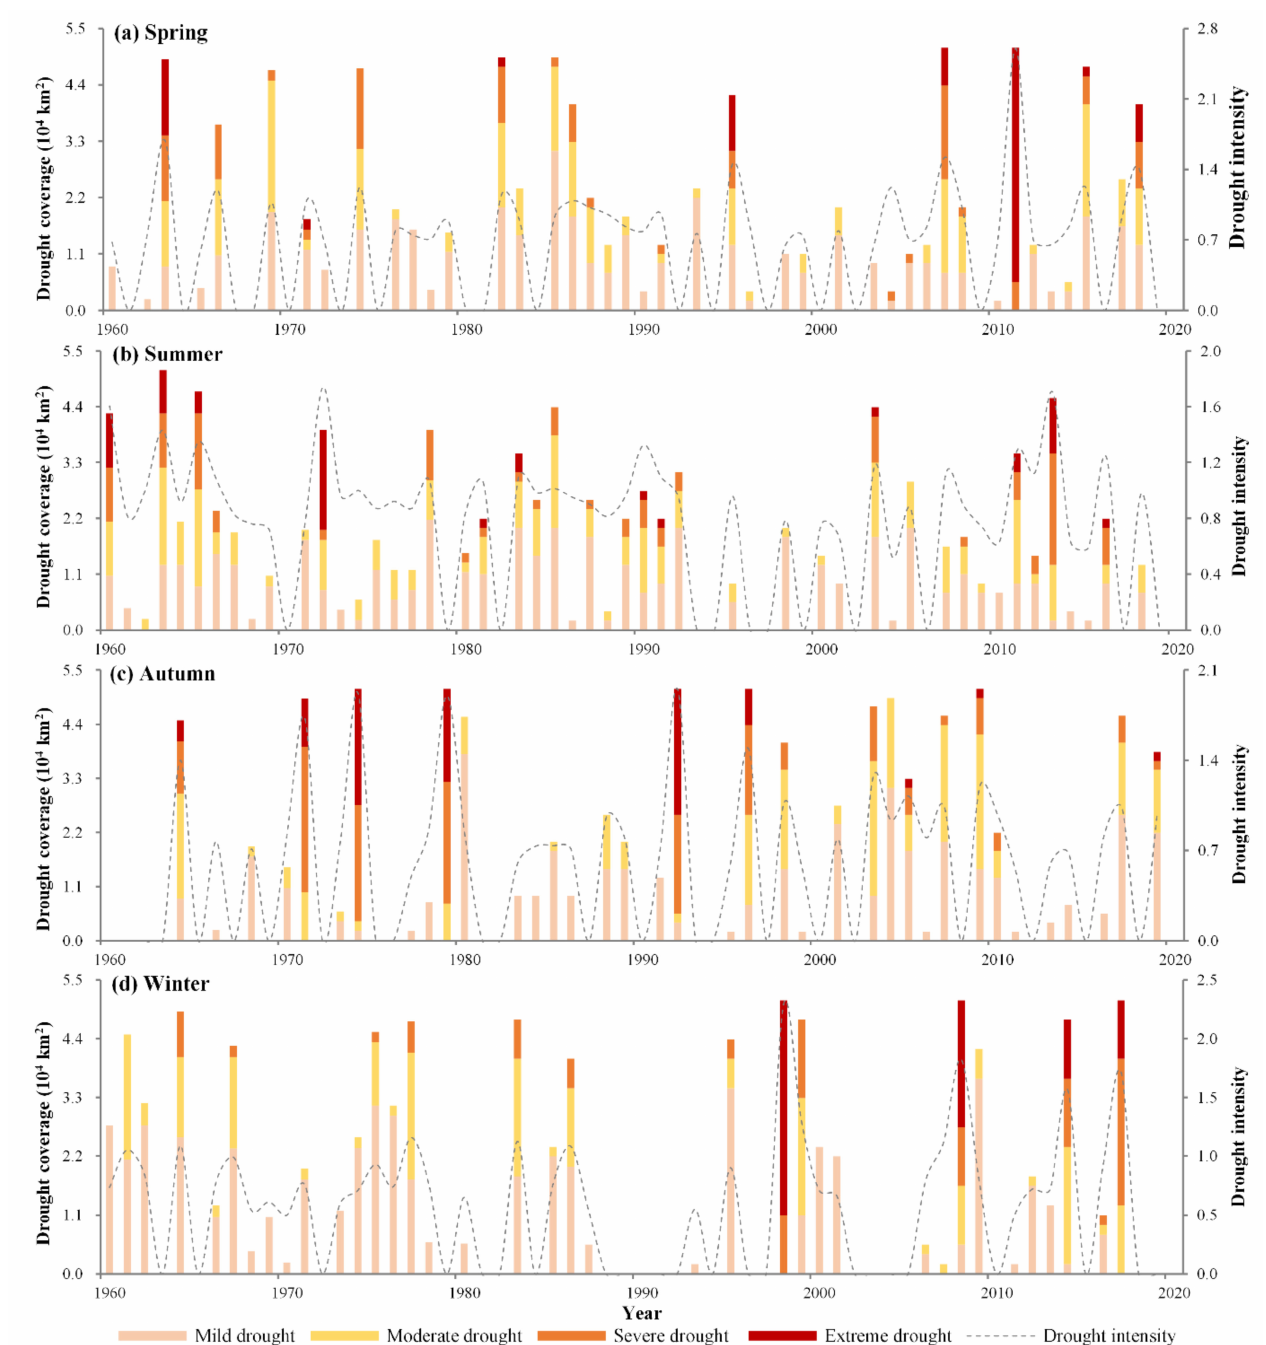
Figure 6. Seasonal drought coverage and intensity in HSDC, 2000–2019. ( a ) Spring; ( b ) summer; ( c ) autumn; and ( d )